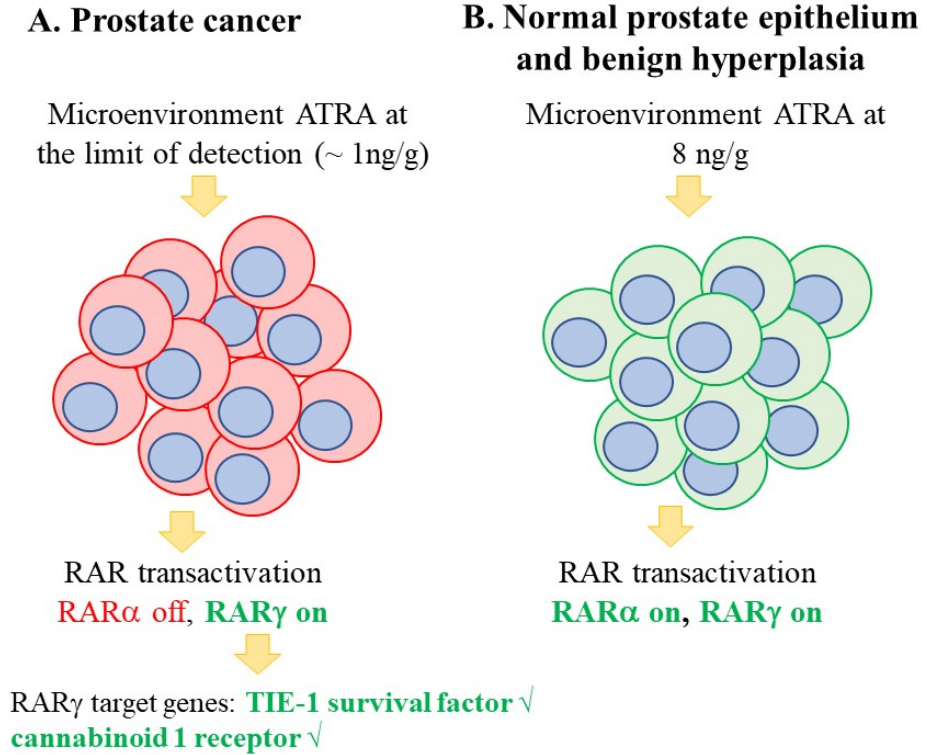
Figure 3. Patients’ prostate cancer cells reside in a low ATRA environment. For tumours, the intracellular level of ATRA is at or near the limit of detection (at ~1 ng/g tissue), and adjacent normal prostate epithelium cells and benign hyperplasia cells see ~8 times more. RAR γ is activated at 0.24 nM ATRA and RAR α at 19.3 nM. Evidence of RAR γ usage within prostate cancer cells is that TIE-1 and the cannabinoid 1 receptor are overexpressed as shown by √ .